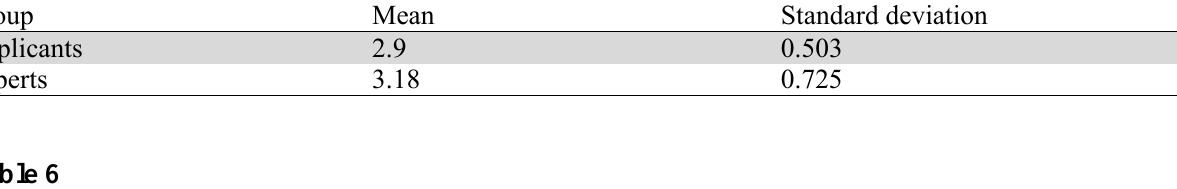
Comparing test to investigate achieving economic goals Statistic